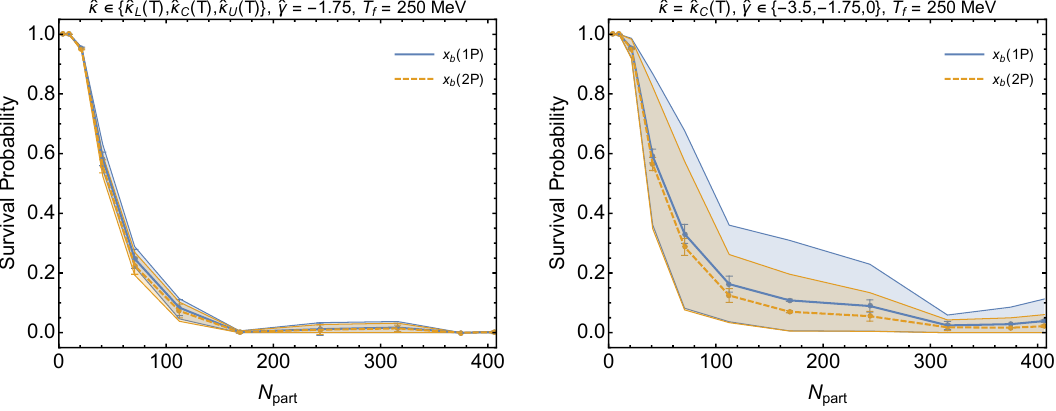
Figure 9 . Survival probability of P -wave bottomonium states versus N part using Gaussian initial conditions to regularize the derivative of the delta function. The bands and error bars shown in the left and right panels correspond to the variations detailed in the caption of figure